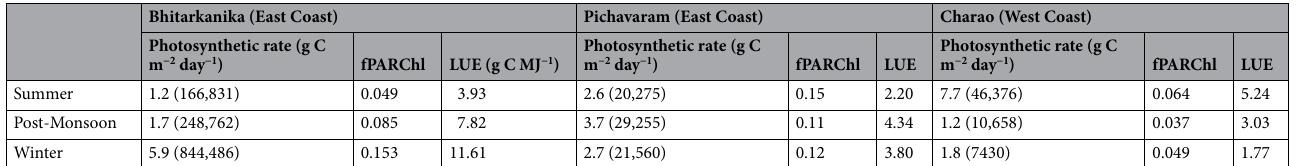
Table 2. Seasonal photosynthetic rates, fPARChl, and LUE values for mangroves in Bhitarkanika (Area extent = 144.25 km 2 ), Picharavaram (Areal extent = 7.86 km 2 ), and Charo (Areal extent = 6 km 2 ) for 2015 25 . LUE values are noted as mean values for dominant mangrove species on all sites. Values in parentheses represent the total overall GPP (carbon fixed per day) for each site.